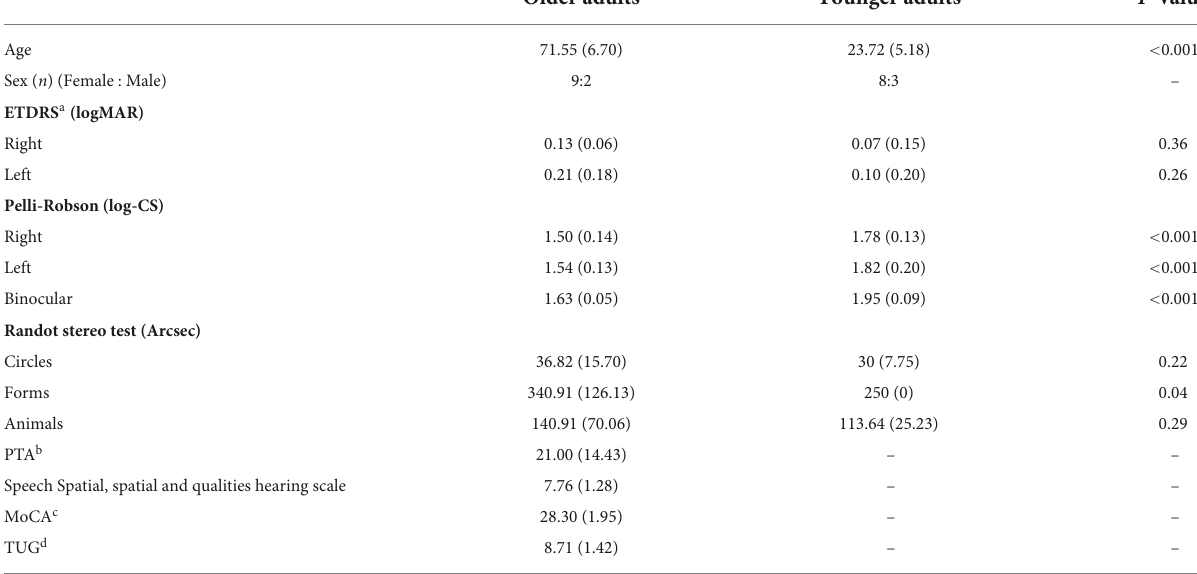
TABLE 1 Summary of baseline assessment